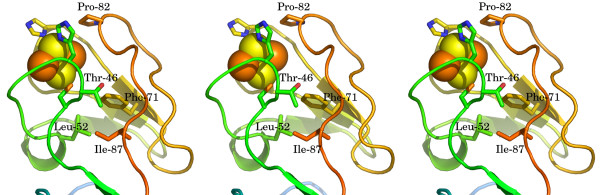
Stereo images showing the conserved residues near the Rieske cluster of BPDO-FB1. The cartoon diagram shows that side chains of Thr-46, Leu-52, Phe-71, and Ile-87 form a highly conserved core among the Rieske oxygenase ferredoxins near the iron-sulfur cluster. The residues flanking Pro-82 are proline in BPDO-FLB400 and some high-potential Rieske ferredoxins, but are not proline in BPDO-FB1. Left and center images are wall-eyed stereo, center and right images are cross-eyed stereo.